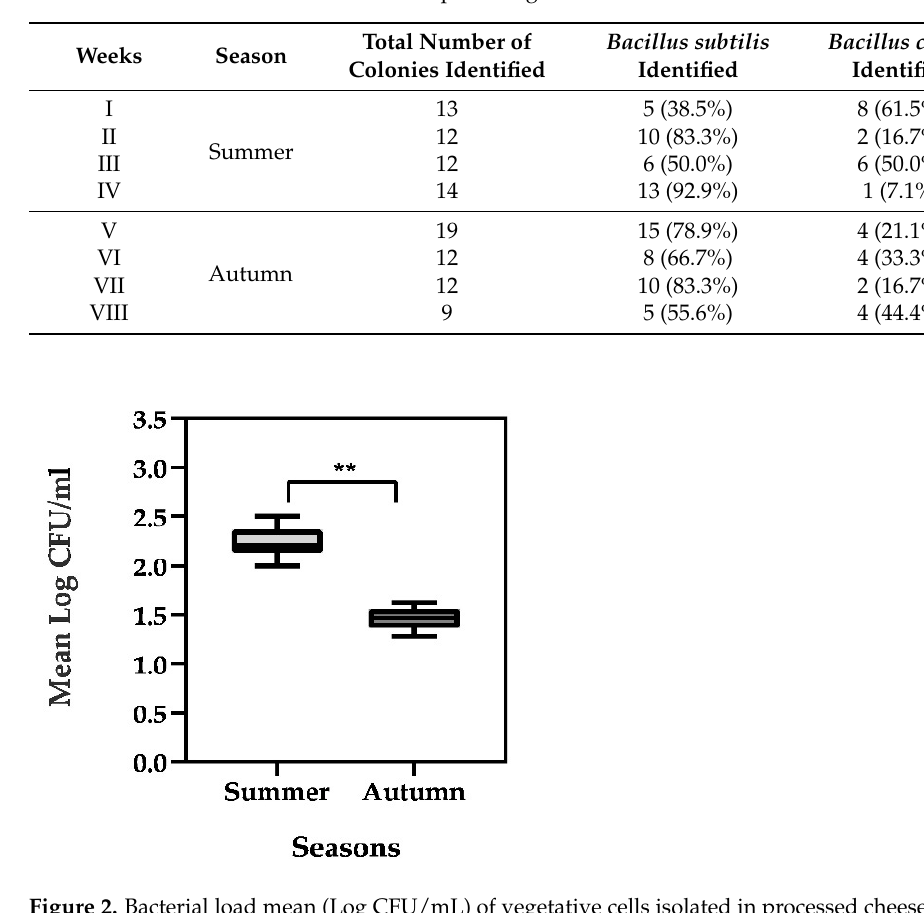
Table 1. MALDI-TOF identification of bacterial colonies grown in PCA. Results showed the number of B. subtilis and B. cereus isolates and the percentage of each week.